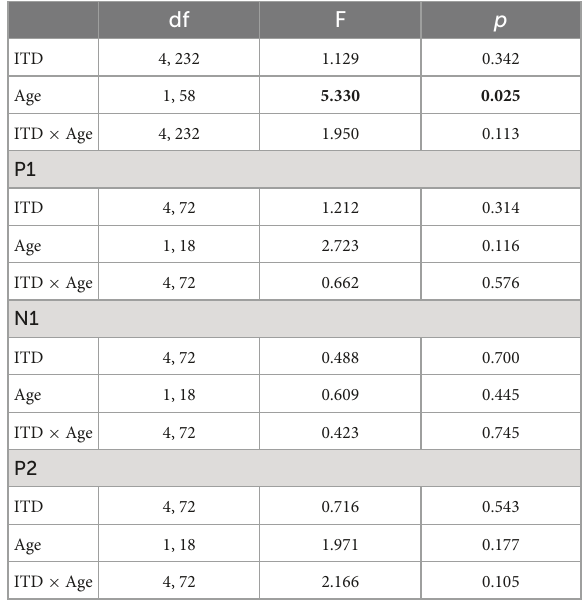
TABLE 1 Repeated-measures analysis of variance (ANOVA) results for cortical auditory evoked potentials (CAEP) sensor-level